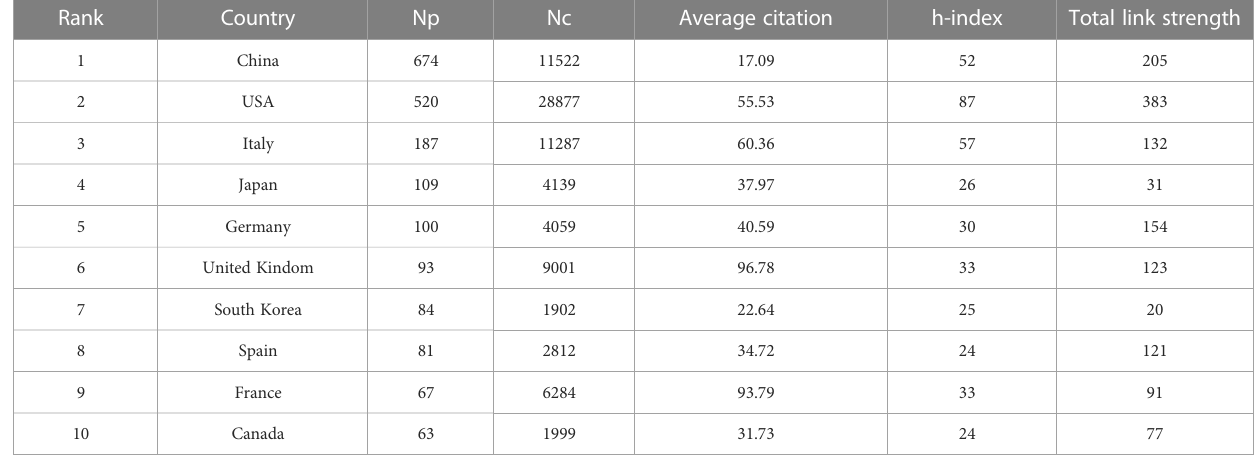
TABLE 1 Top 10 countries with the most published research on the gut-liver axis in NAFLD. Rank